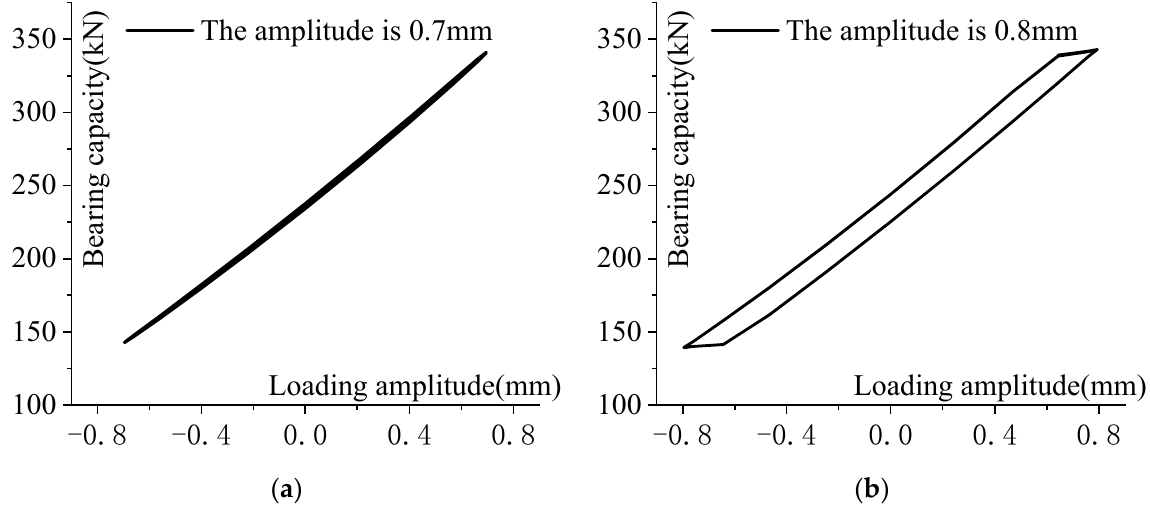
Table 2. Setting of working conditions for changing wall thickness/diameter (unit: mm). Figure 8. Hysteresis curve of ring spring for different amplitudes: ( a ) 0.7 mm; ( b ) 0.8 mm.